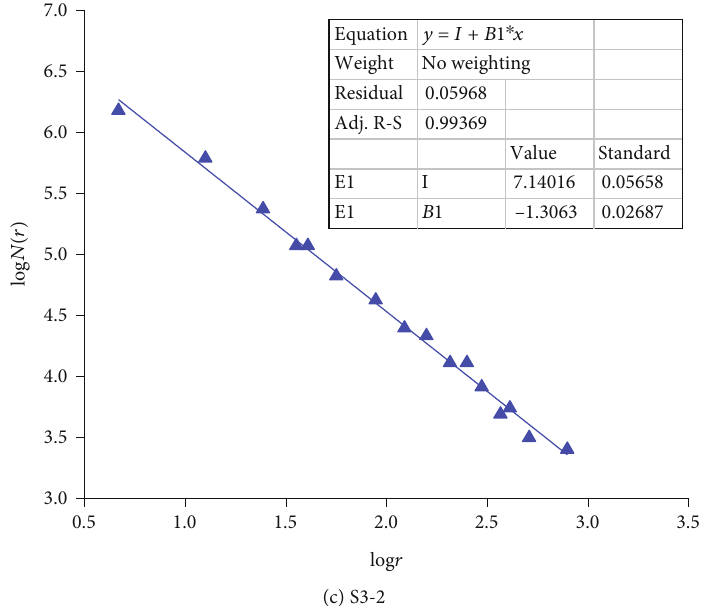
Figure 11: The fractal dimension of the fi nal fracture